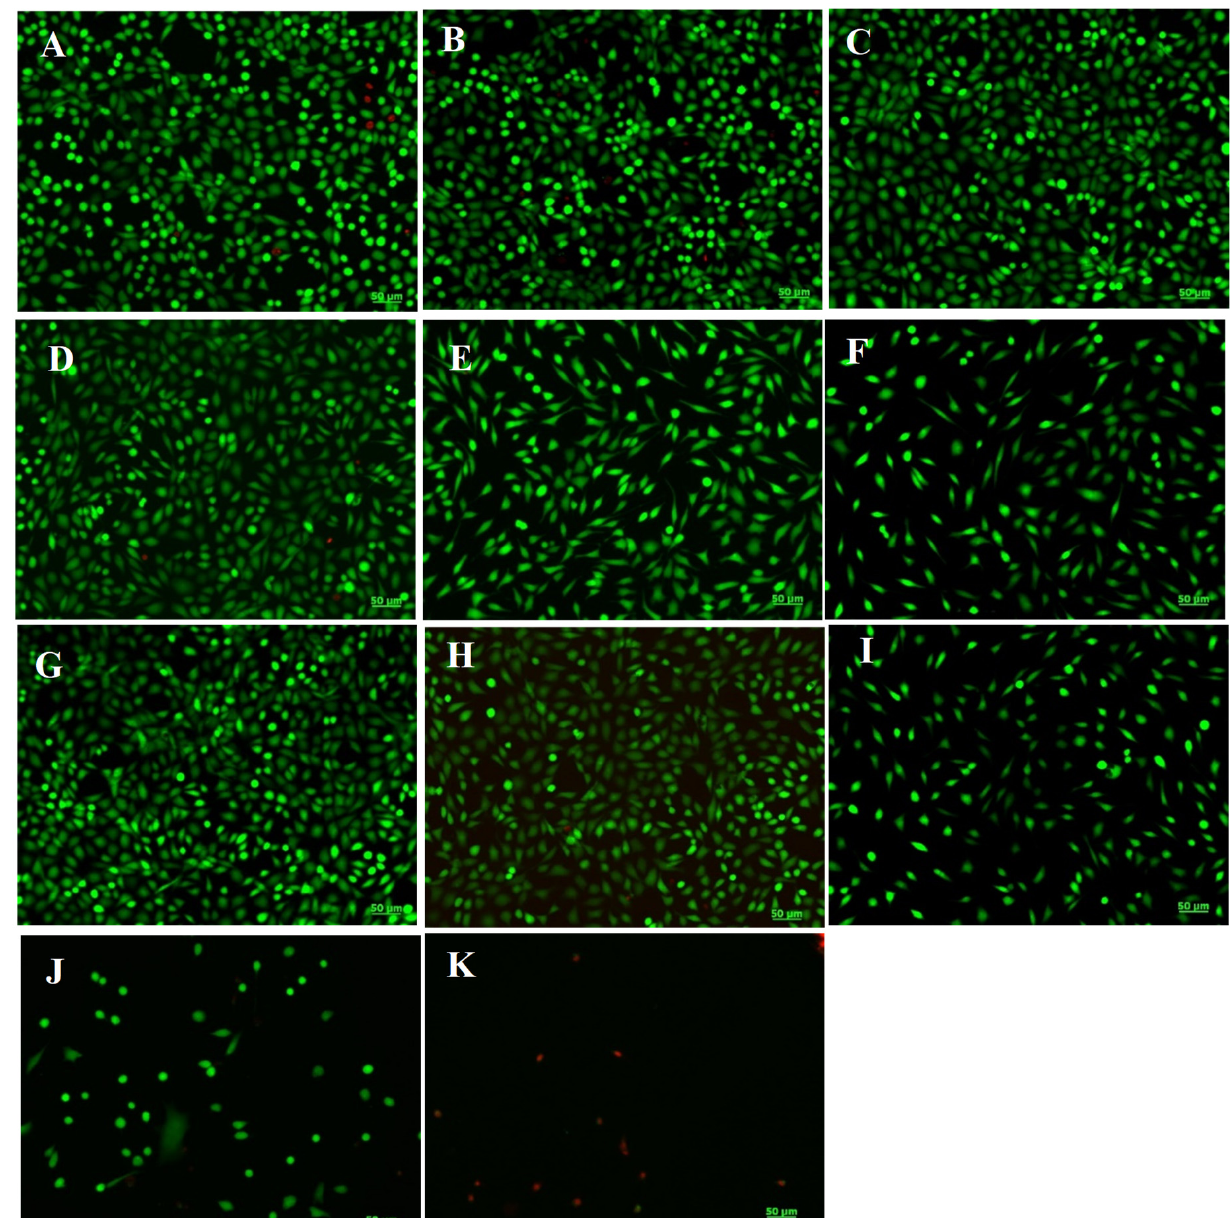
Figure 6. Fluorescent images of L929 live (green) and dead (red) cells, untreated (control, ( A )) and treated with AV5 ( B – F ) and AV10 ( G – K ) hydrogels at different concentrations for 48 h. ( B , G )—10 mg/mL; ( C , H )—25 mg/mL; ( D , I )—50 mg/mL; ( E , J )—75 mg/mL; ( F , K )—100 mg/mL. Scale bar = 50 µm.